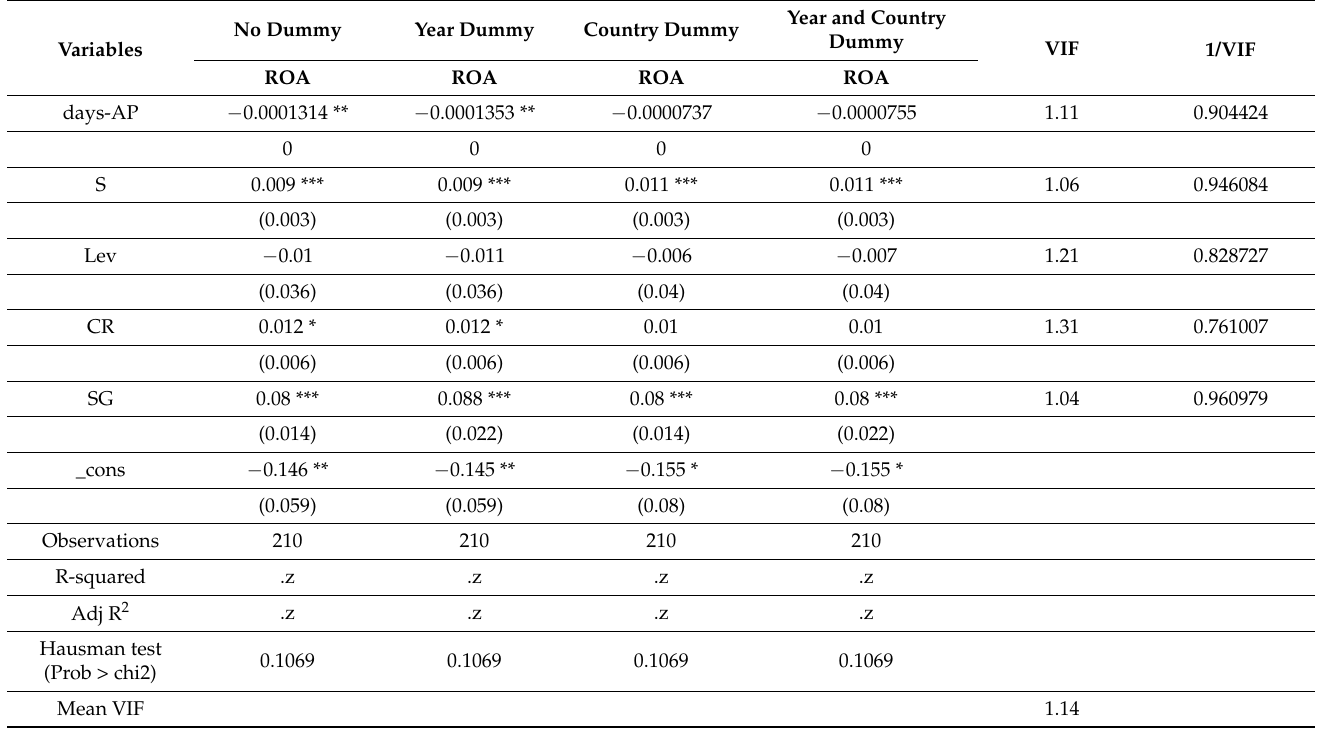
Table 11. Results of the random effects of days-AP on ROA, as per panel regression (pandemic period, 2020–2021).